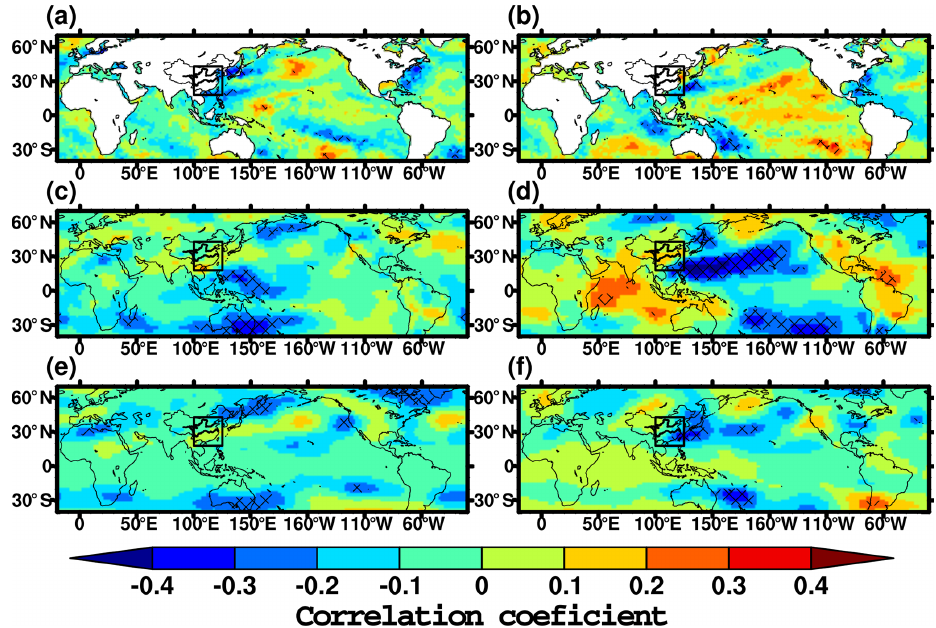
Figure 10. Correlation coefficients in the wet season. (a) Sea surface temperature and PC1, (b) mean sea level pressure with PC1, (c) geopo- tential height at 500hPa and PC1, (c) sea surface temperature and PC2, (e) mean sea level pressure with PC2 and (f) geopotential height at 500hPa with PC2. Hatching denotes the regions with statistical significance at the 95% confidence level. The black rectangle denotes eastern China.